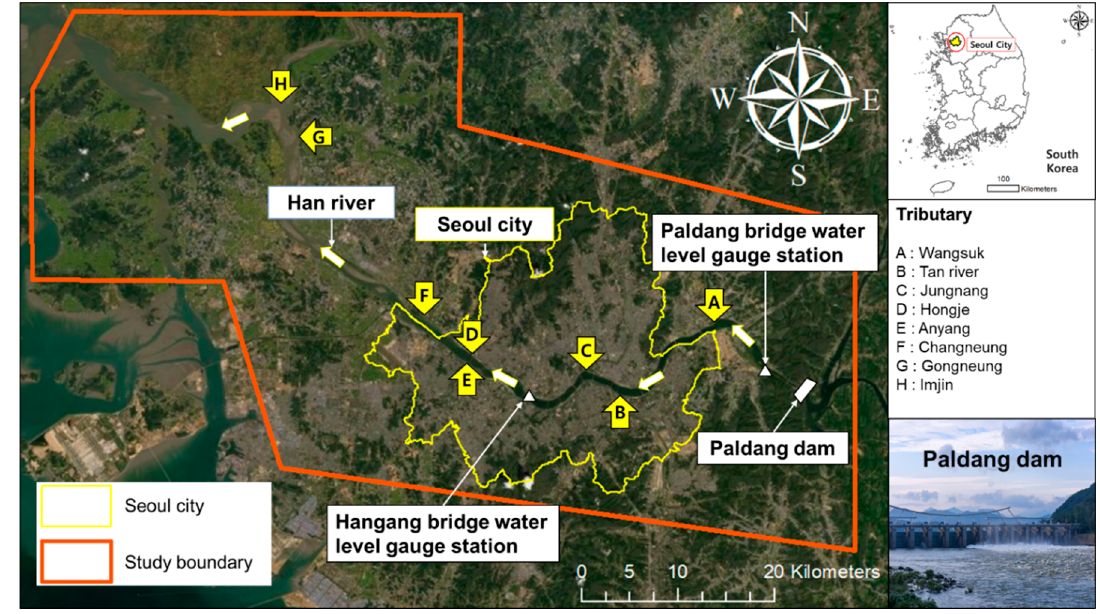
Figure 3. Study boundary, tributaries, and Paldang Dam.